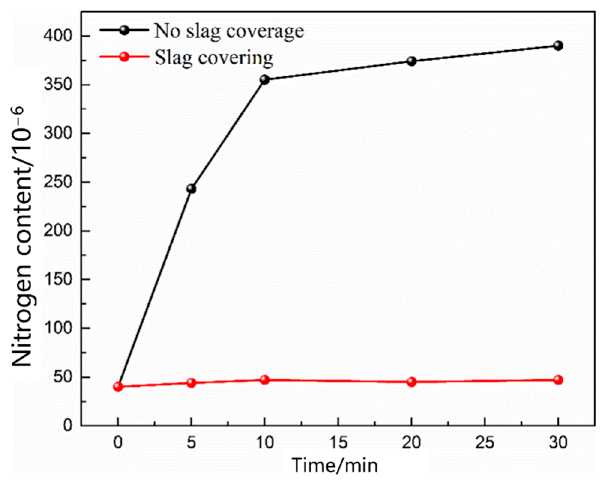
Figure 11. Effect of slag covering on the nitrogen content in the molten steel.